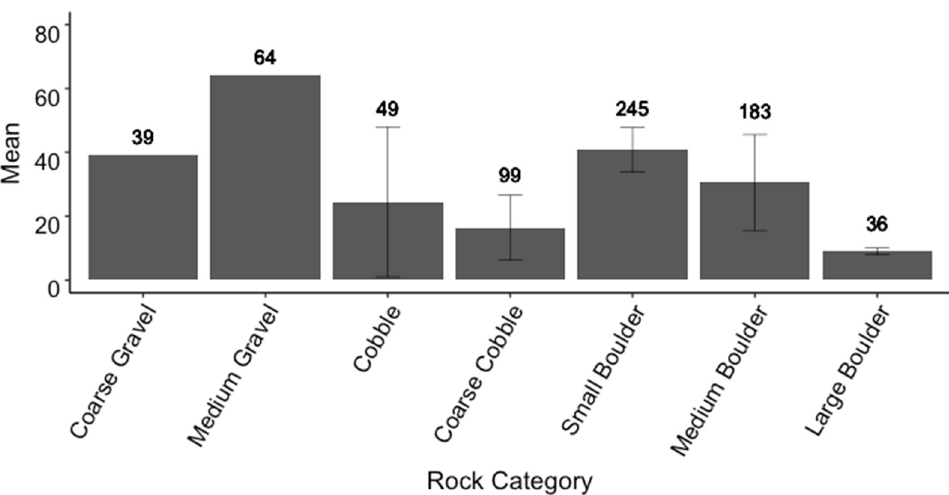
Figure 2. Mean (±SE) number of rocks measured in the representative radial plots in each of the boulder categories across the subset of sampled sites. Numbers above each bar refer to the frequency of rocks counted in each category. Refer to Table 1 for definitions of rock sizes. Note: There is no SE for coarse and medium gravel as these rock sizes were only counted in the radial plots at Port Macquarie. Table 2. List of sites and sampling times.